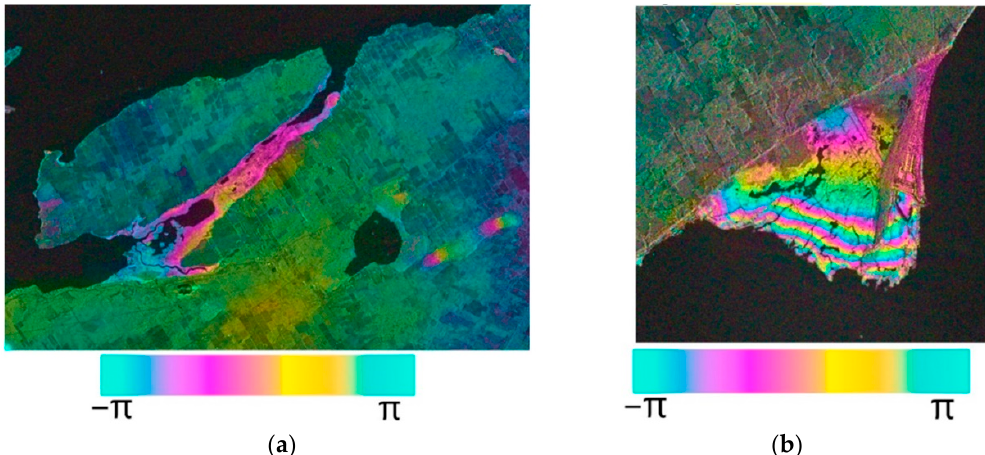
Figure 18. Example of interferograms in our two study areas. ( a ) Bay of Quinte, center area with purple/pink and yellow color is cattail marsh, lower right area with purple/pink and yellow color is swamp. ( b ) Long Point, the center area with purple/pink, yellow, and blue fringes are marsh with mixed cattail/Phragmites.